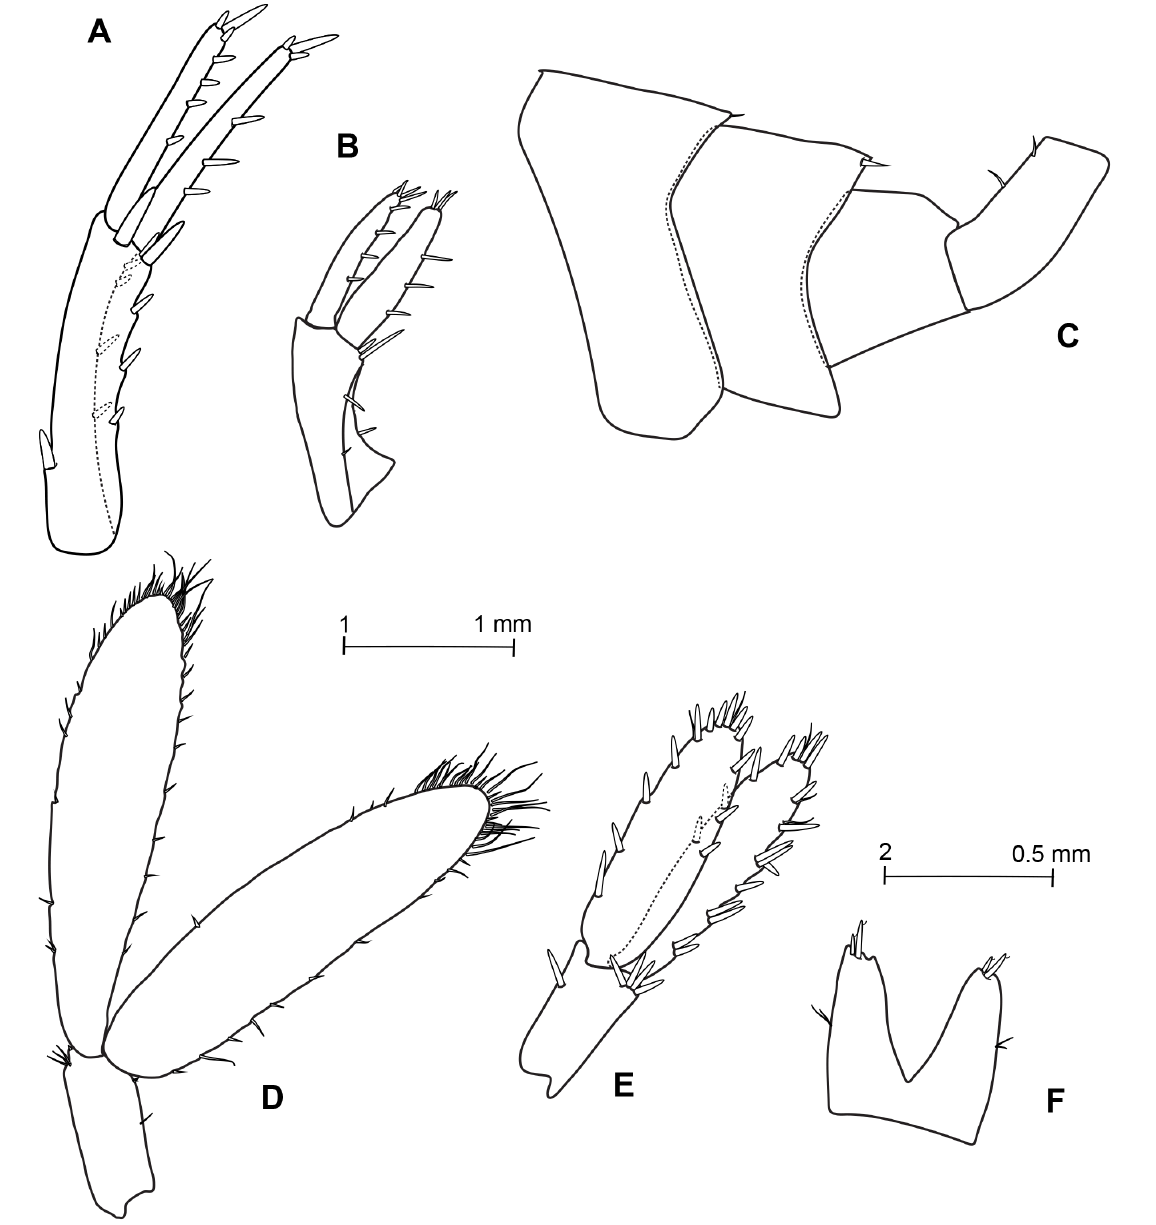
Fig. 5. Quadrivisio laleyi sp. nov. A–D ., F . Holotype, ♂, 7.5 mm, MNHN IU-2017-209. E . Paratype, ♀, 7.0 mm, MNHN IU-2017-211. A . Male uropod 1 (scale 1). B . Male uropod 2 (scale 1). C . Male urosome (scale 1). D . Male uropod 3 (scale 1). E . Female uropod 3 (scale 1). F . Male telson (scale